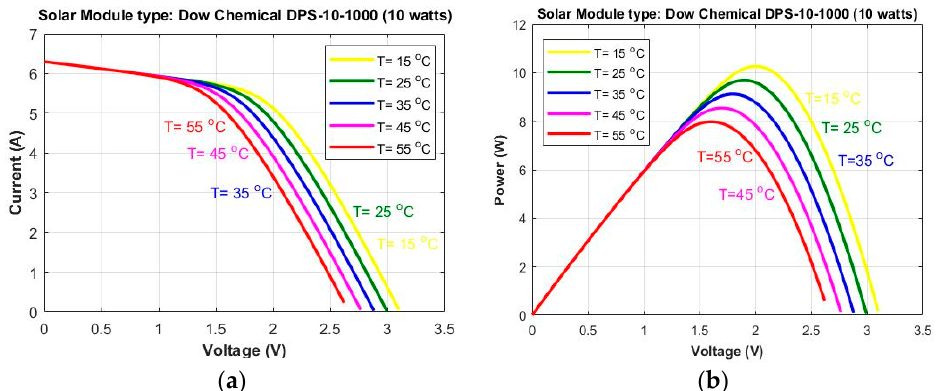
Figure 5. Solar Panel characteristics with variations in Temperature ( o C). ( a ) I–V Characteristics; ( b )